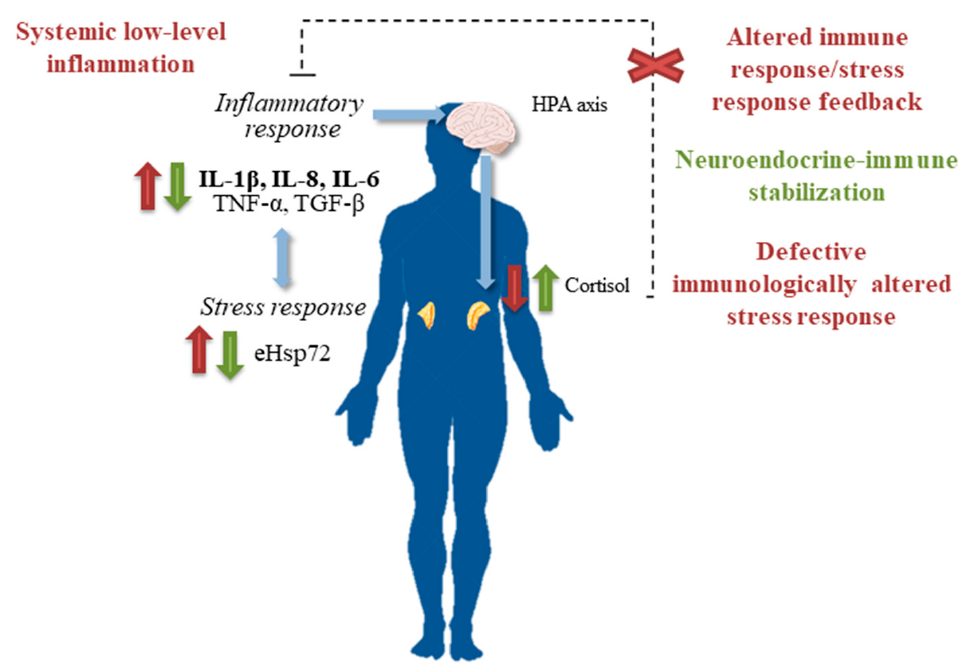
Figure 1. Neuroendocrine-immune stabilization as a proposed mechanism of effectiveness of a cycle of balneotherapy underlying pain alleviation in osteoarthritis (OA) patients [49]. Elevated systemic concentrations of pro-inflammatory cytokines are unable to activate cortisol release in OA patients, and the low concentration of cortisol cannot inhibit the high systemic levels of pro-inflammatory cytokines [60] (symbols and text in red). Balneotherapy increases systemic cortisol levels that in turn induce an anti-inflammatory response that is manifested by a decrease in the concentration of circulating pro-inflammatory cytokines (symbols and text in green). Balneotherapy decreased the unhealthily elevated eHsp72 concentrations in OA patients, also contributing to the anti-inflammatory effects [49]. Up and down arrows represent increases and decreases in the systemic concentrations of cytokines, eHsp72, and cortisol.